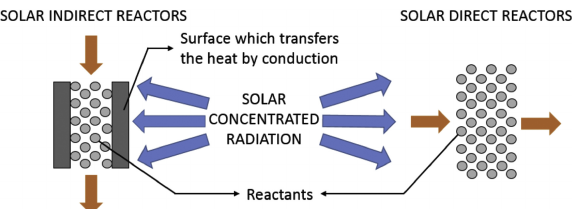
Figure 1. Schematic representation of the difference between directly and indirectly irradiated reactors/receivers. Reprinted from [6] with permission from